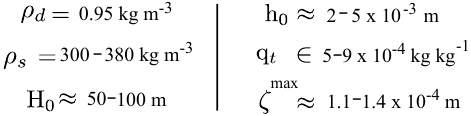
Figure 5. Schematic of the box model and description of the input parameters (isotopes excluded). ζ max is the maximum value of the surface height anomaly at the end of the cooling phase, calculated with two extreme values of ( H 0 , ρ s ). The height of the SSDC snow samples gives an estimation of h 0 . ρ d and ρ d have been calculated from 100 snow samples per day, surface pressure, temperature and relative humidity observed at Kohnen from December 2013 to Jan- uary